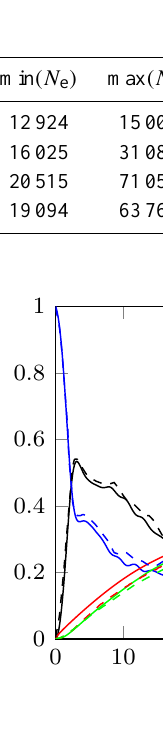
Figure 4. Energy budget evolution with time for simulation with adaptivity options A3 (solid lines —) compared against 2-D results from Espath et al. (2014) (dashed lines - - -). Values are normalised by the initial potential energy, E T